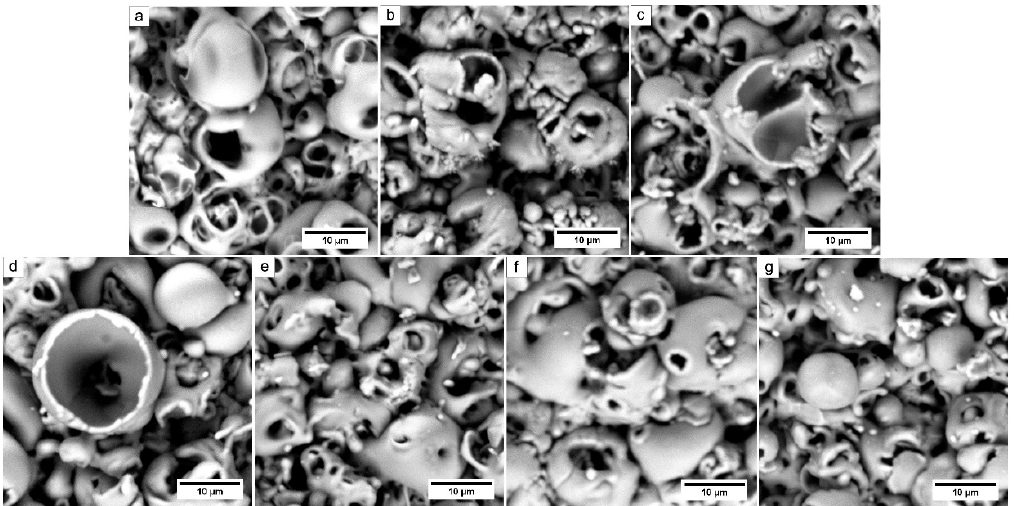
Figure 1. SEM micrographs of PEO CaP subcoating ( a ) and PEO + RFMS HA ( b ), Sr-HA ( c ), Mg-HA ( d ), β -TCP ( e ), Sr- β -TCP ( f ) and Mg- β -TCP ( g ) composite coatings.